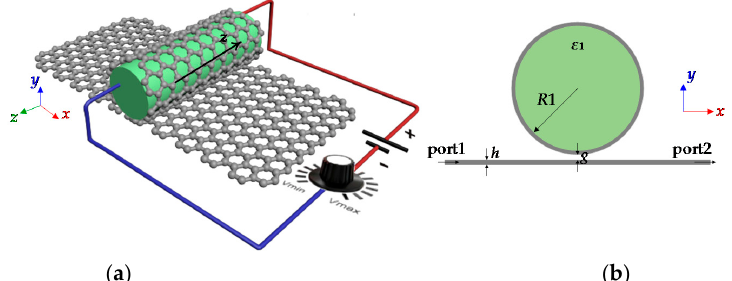
Figure 3. ( a ) Schematic diagram of the sensor model based on the cylindrical dielectric loaded with a thin layer graphene and monolayer graphene waveguide; ( b ) Cross-section of the structure.